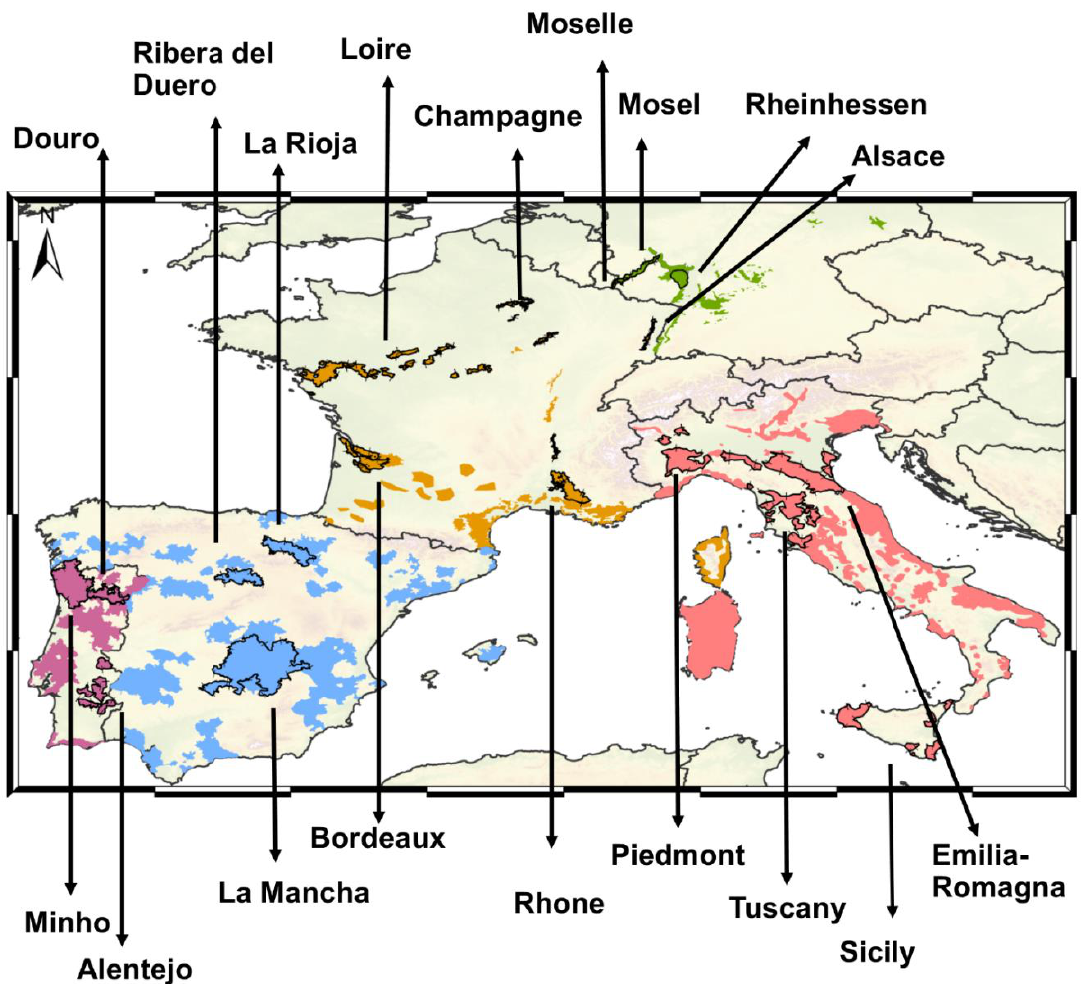
Figure 1. Selected wine regions in Europe (18), highlighted by a black line contour, and their corresponding designations. Other wine regions are also outlined, with different color shadings for different countries.